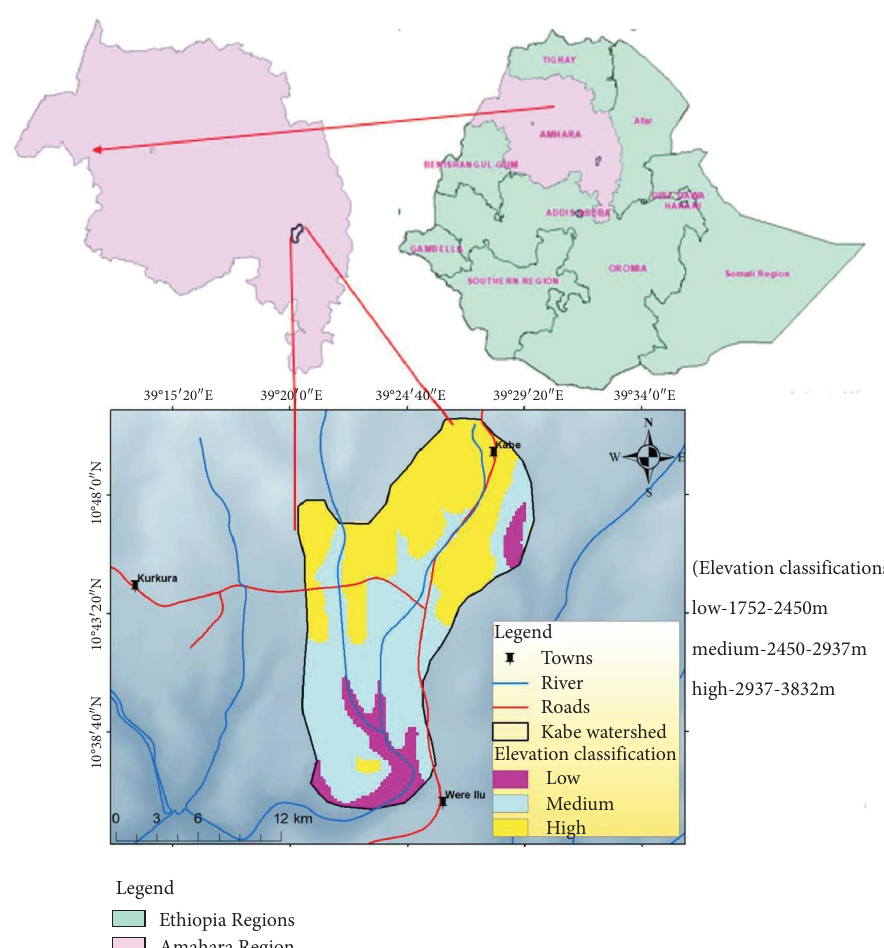
Figure 1: Location of Kabe watershed (study